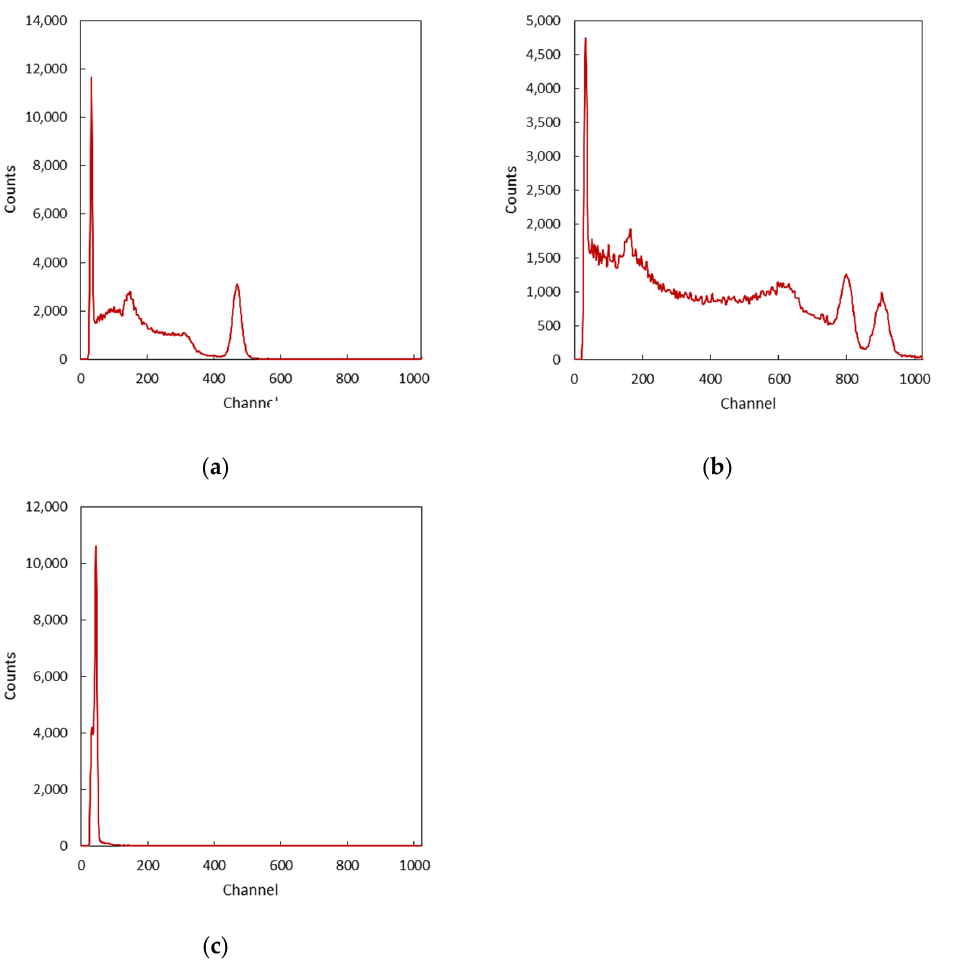
Figure 9. Measured spectra used for energy calibration: 137 Cs ( a ), 60 Co ( b ), 241 Am ( c ).